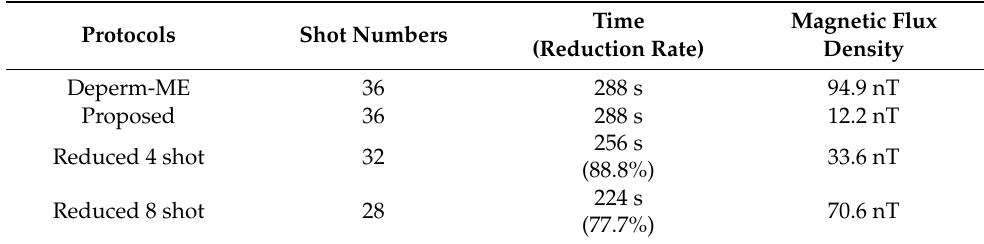
Table 2. Measured results of the SPCC by reducing the demagnetization